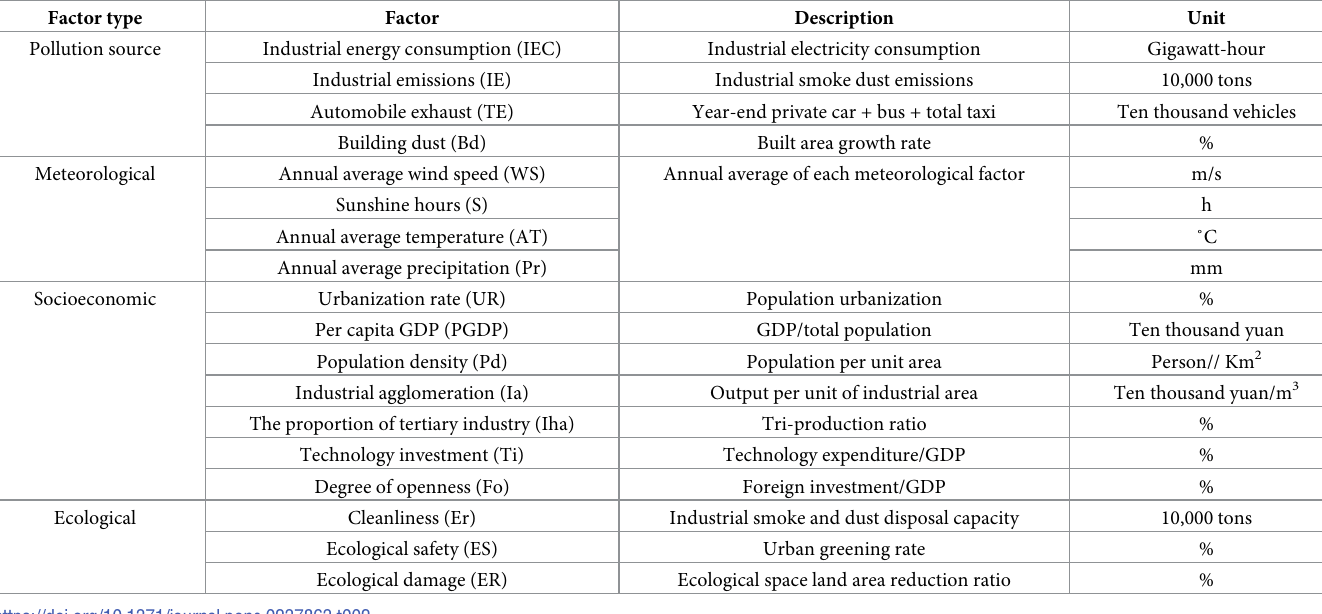
Table 2. Factors affecting PM 2.5 concentration in coastal urban agglomerations considered in this study.